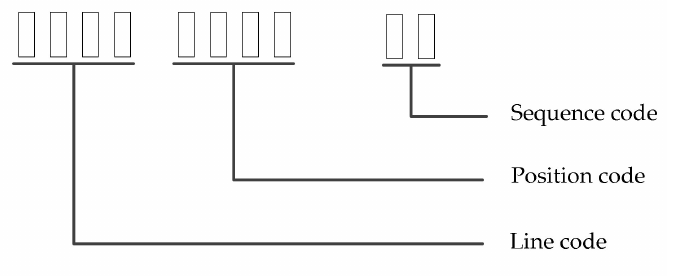
Figure 4. The code structure of the train operation department